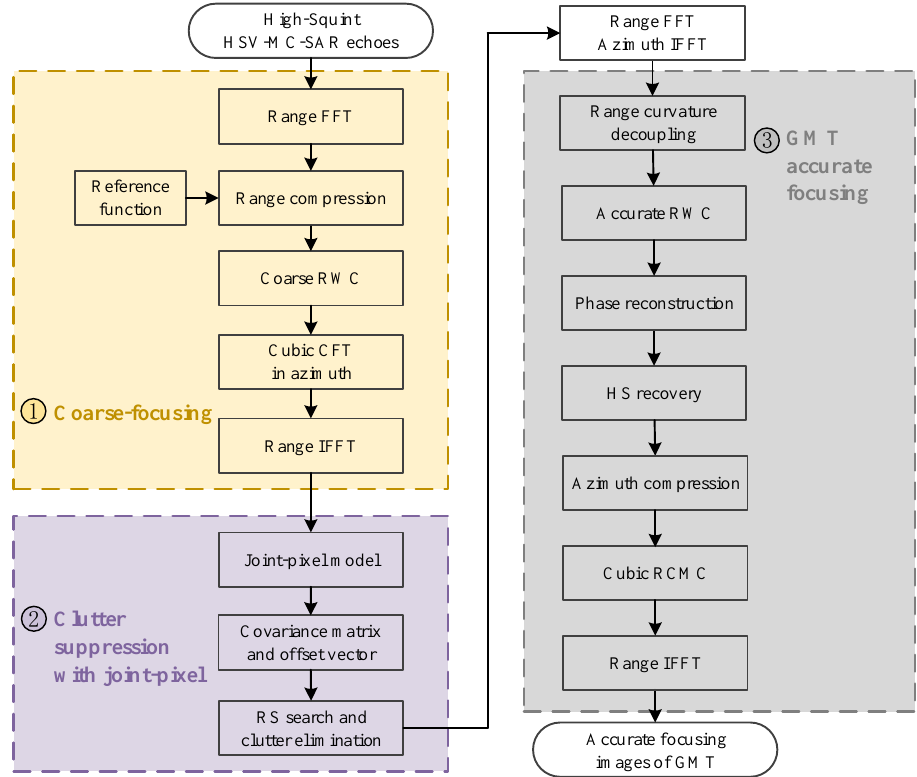
Figure 2. The flowchart of our proposed